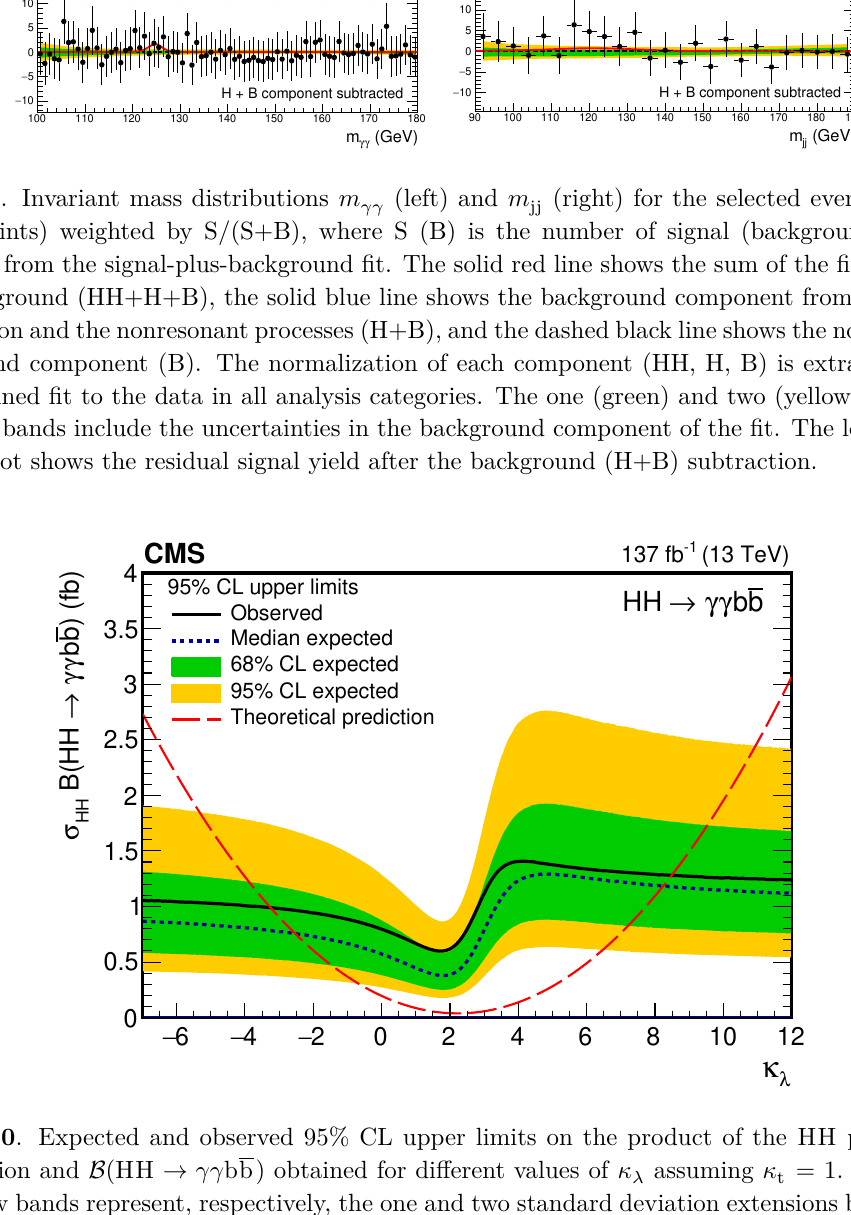
assuming κ = 1. The green λ t